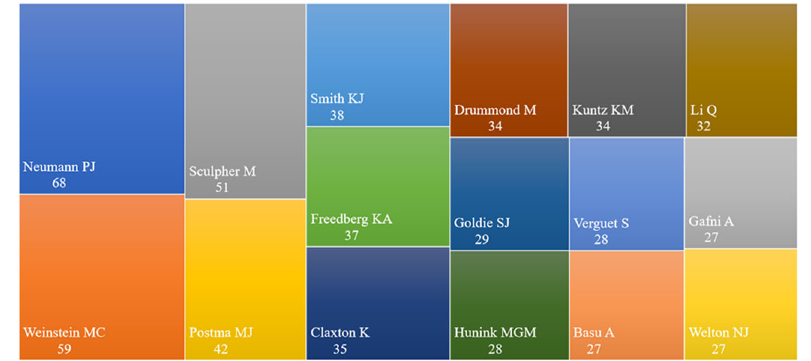
Fig. 5 Publications by author. Source: Web of Science, 2021.